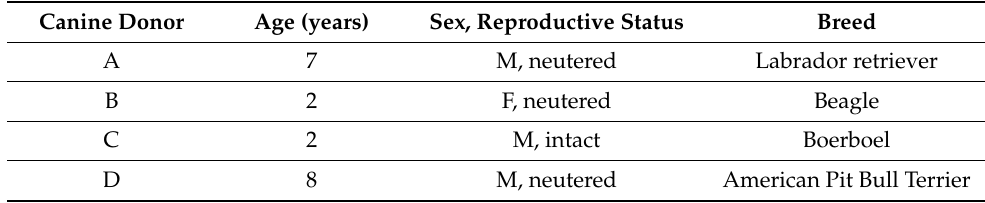
Table 1. Characterization of canine